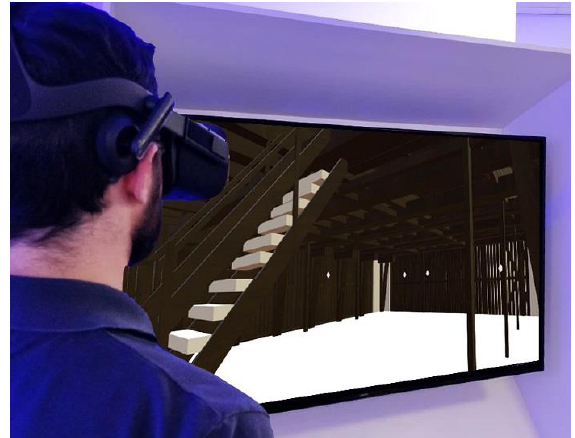
Figure 4: Fruition of the internal spaces of the 3D model’s farmhouse through the use of the AR viewer.